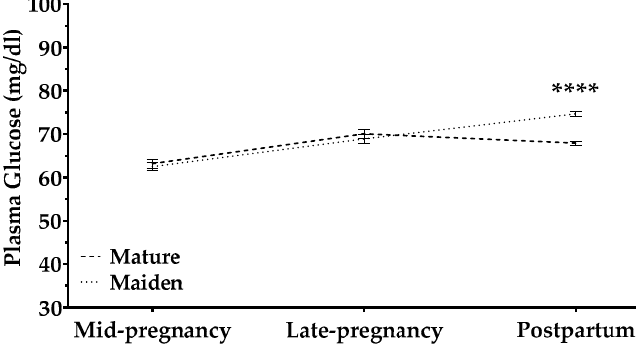
Figure 4. Plasma glucose concentrations (mg/dL) in mature ewes (dashed line) and maiden ewes (dotted lines) throughout the study period. Data are mean ± S.E.M. The time × age-group interaction was significant ( p < 0.0001). Asterisks indicate significant differences between age groups (**** p < 0.0001).